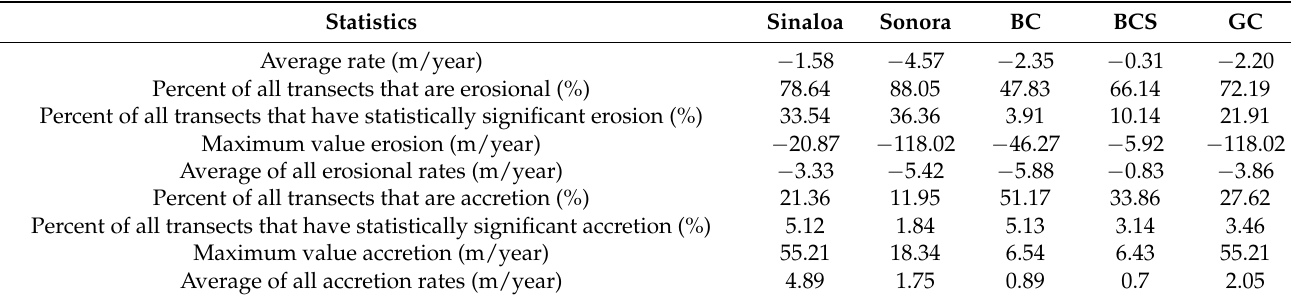
Table 4. Shoreline change rates by LRR.